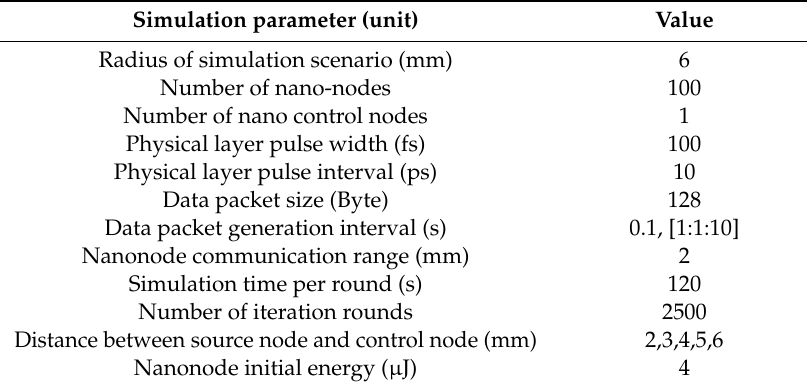
Table 1. Simulation parameter setting.